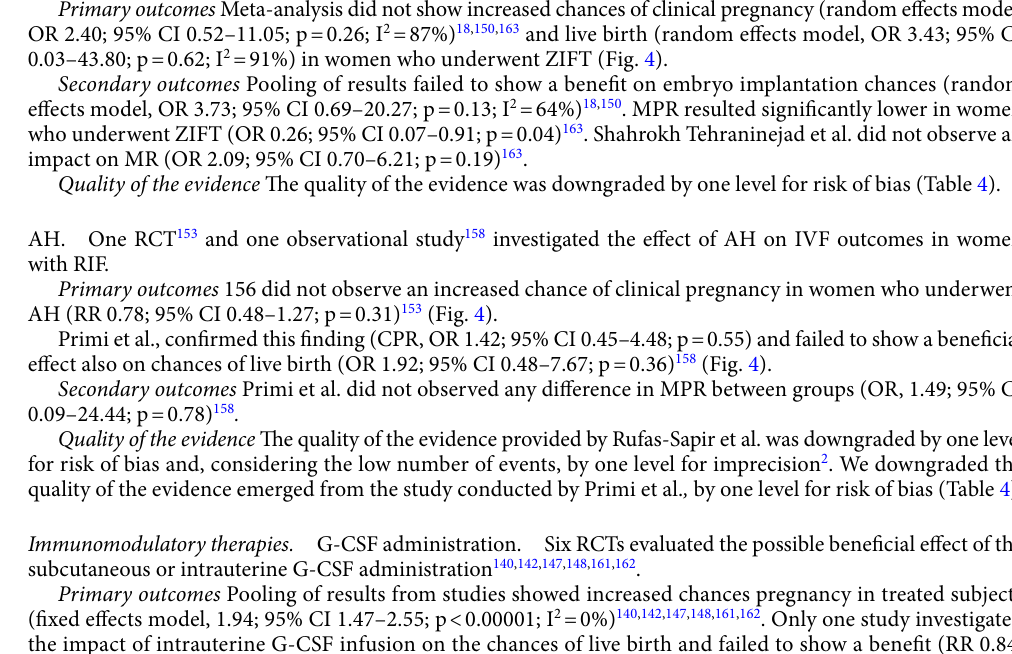
Table 3. Assessment of risk of bias of non randomized studies according to the ROBINS-I